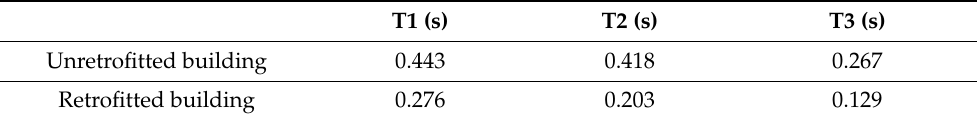
Table 3. First three vibration periods of the facade wall out of its plane.